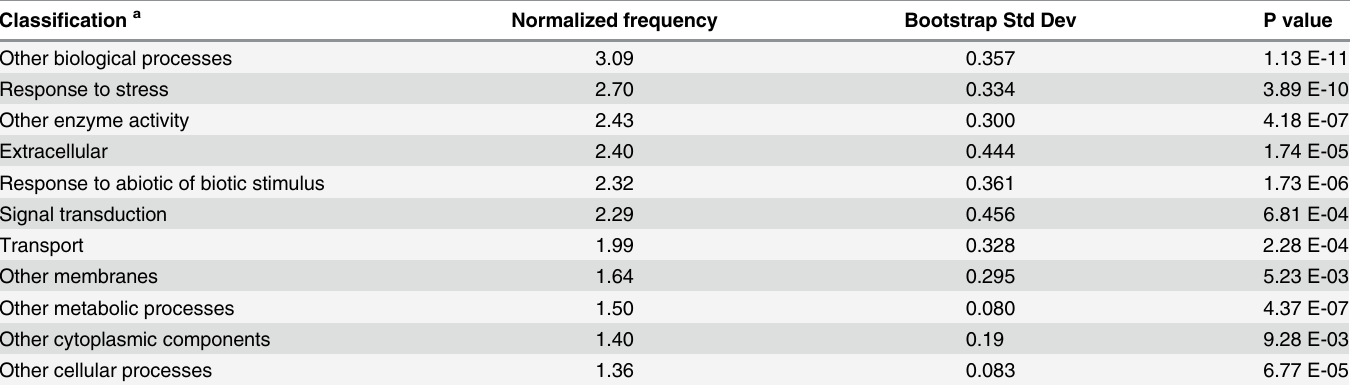
Table 2. Functional enrichment of genes preferentially expressed in peels at 16 days post pollination (dpp). Transcripts were selected based on crite- ria of top 5% for expression in peel and top 5% for increase in 16 dpp peel vs. 8 dpp peel. The resulting 105 transcripts had > 72% of reads in peel samples and > 8-fold increase above 8 dpp peel